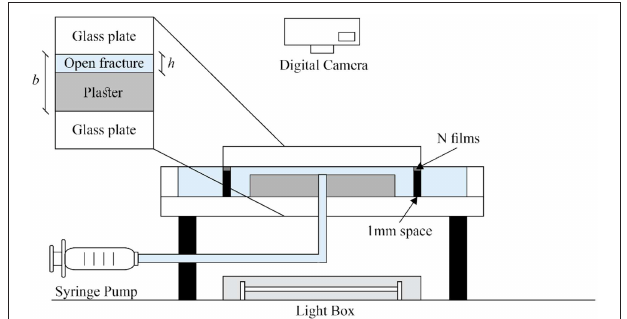
FIGURE 1 | Schematic diagram of the experimental setup. A circular Hele-Shaw cell (spacing 1 mm) contains a plaster plate with a small gap h above the plaster upper surface. The aperture is created artificially by the spacers and kept clamped. Water is withdrawn by a syringe pump from the center of the bottom glass plate (the outlet), where it flows radially inwards. The plaster plate is surrounded by freshwater. The model is illuminated from below by a light